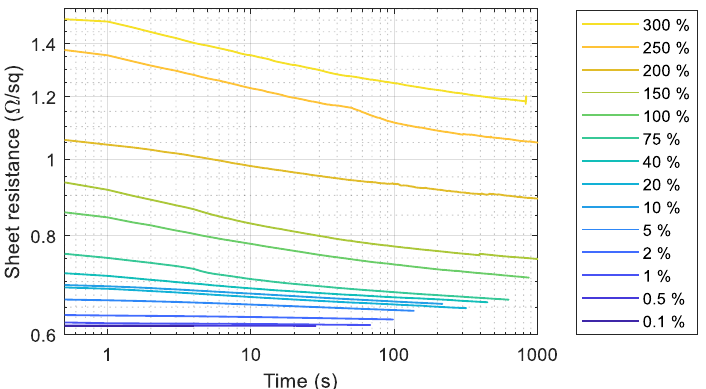
Figure 4. The sheet resistance of the inkjet-printed silver wires after stretching cycles that consist of a stretching of 20% that breaks the conductive paths in the wire and a relaxation after a hold-time of 10 s.